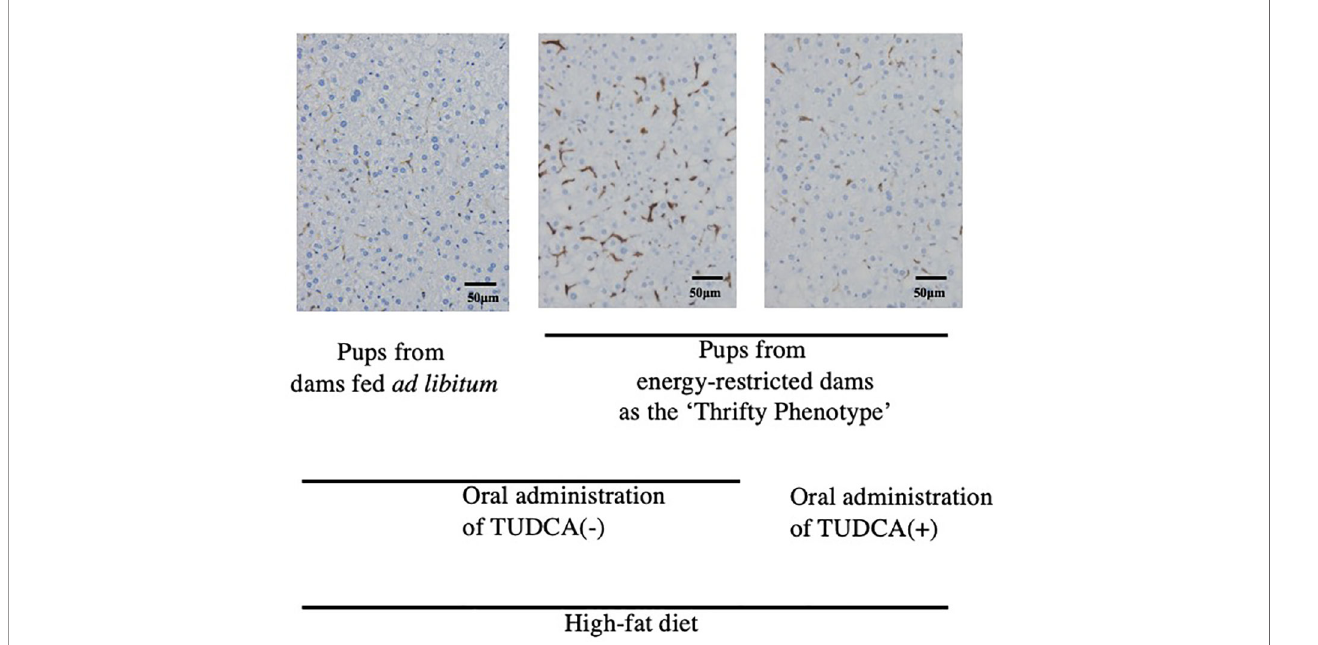
FIGURE 1 | Immunohistochemistry of F4/80-positive hepatic macrophages from 22-week-old pups fed a high-fat diet (Reference 41). Positive staining is brown. TUDCA, Tauroursodeoxycholic